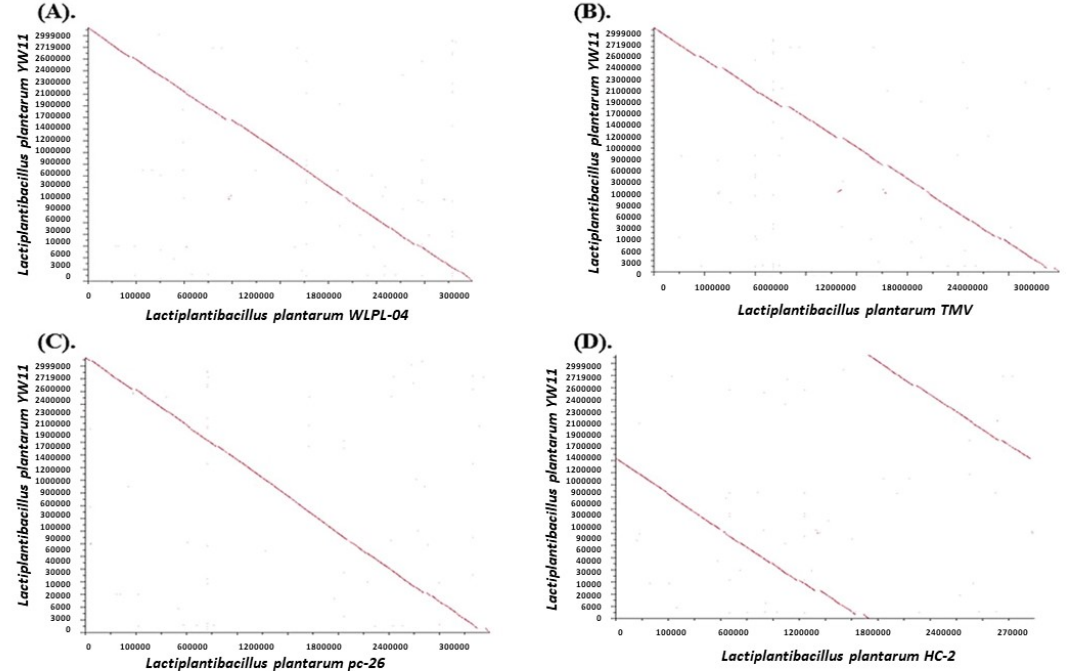
Figure 7. Collinearity relationship of YW-11 with ( A ) WLPL04, ( B ). TMW, ( C ) pc-26 and ( D ) HC-2, strains of Lactiplantibacillus plantarum using SEED Viewer of RAST.